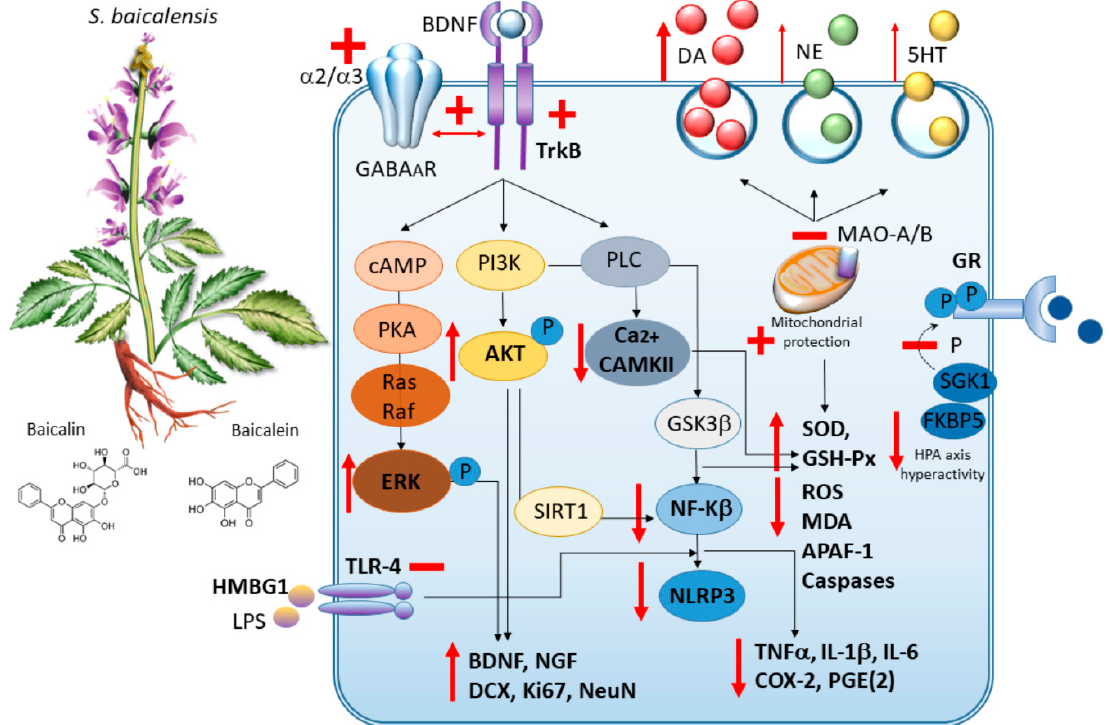
Figure 2. S. baicalensis : molecular mechanisms underlying neuroprotection and anxiolytic / antidepressant-like e ff ects. By acting as MAO A / B inhibitors, S. baicalensis and its bioactive ingredients (mostly baicalin and baicalein) induce monoamine, and mostly DA release. At the same time, they act as partial, subtype-selective GABA A receptor ligands and also foster the interaction of GABA A receptors with TrkB to potentiate GABA-induced signaling. By increasing cAMP / pERK and PI3K / pAKT signaling, they promote the synthesis of neurotrophic factors (BDNF and NGF) as well as neurogenesis. S. baicalensis promotes anti-inflammatory e ff ects through inhibition of HMBG1 / TLR4 / NF-k, AKT / SIRT1 / NF-k, and GSK3 / NF-k axes. This leads to a reduction in NLRP3 and proinflammatory cytokines levels. At the same time, S. baicalensis promotes anti-oxidant e ff ects which are bound to both Ca2 +/ CAMKII pathway inhibition and mitochondrial protection. By downregulating SGK1 and FKBP5, S. baicalensis also counteracts alterations in glucocorticoid receptors (GR) associated with phosphorylation of its crucial serine residues and HPA axis hyperactivity.